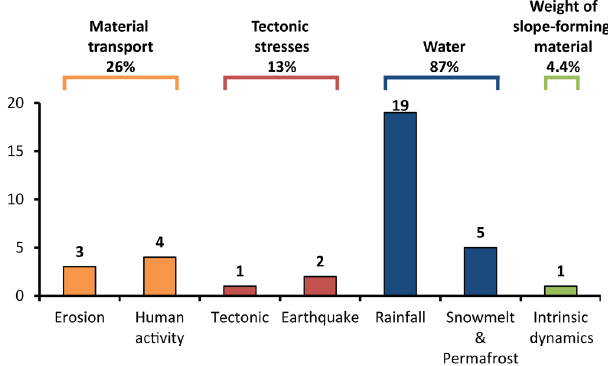
Fig. 2. Triggering mechanisms involved for the 23 reported instabil- ities and grouped according to Terzaghi’s (1950) agents. The total can be over 23 (and 100%), since the reported studies can be af- fected by more than one triggering